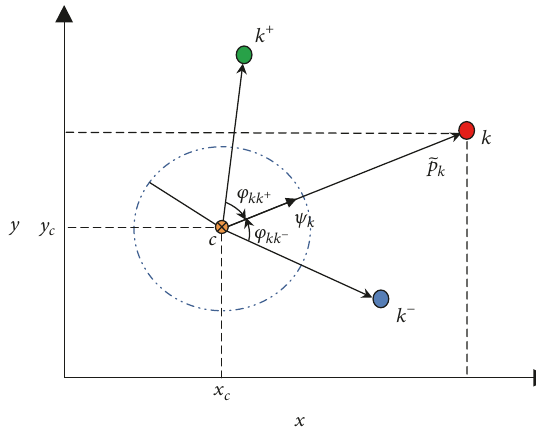
Figure 1: Agent, target, and the graphical view of notations.